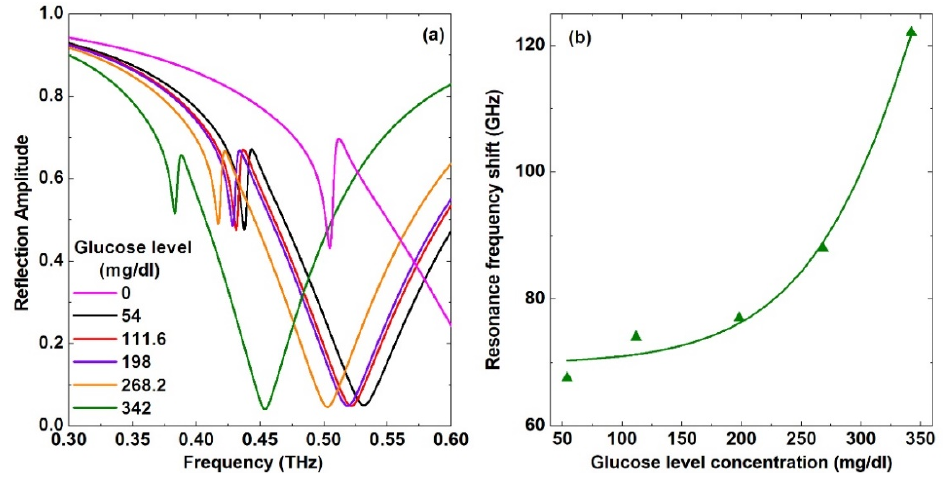
Figure 3. ( a ) Reflection spectra of the symmetric complementary split rectangular resonators for a sweep of glucose concentration levels between 54 and 342 mg/dL; ( b ) The corresponding resonance frequency shift versus the glucose level concentration.